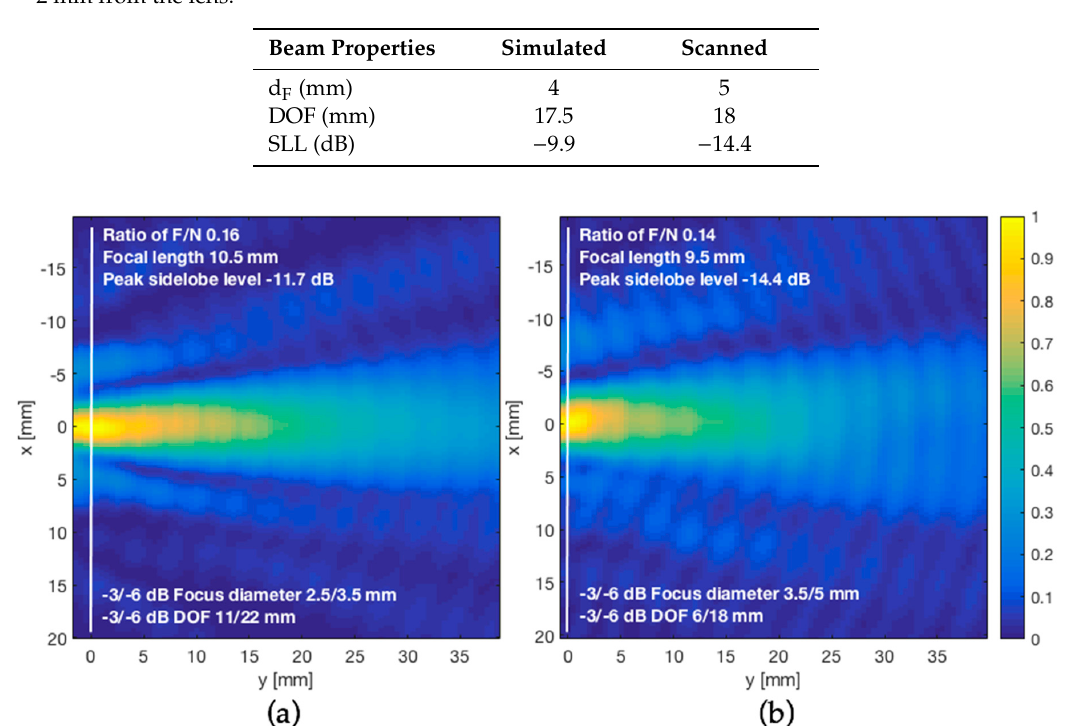
Figure 11. Ultrasound can be focused through human skull phantom. Experimental measurements of acoustic pressure field emitted from a 445 kHz axicon lens. ( a ) Free space without skull; ( b ) after transcranial transmission through skull bone phantom. White line indicates the focus.